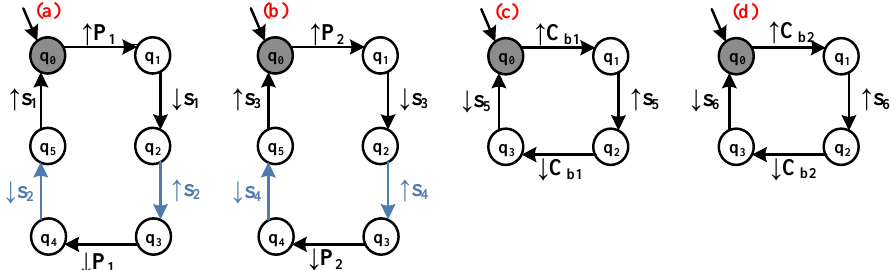
Figure 10. Local controllers LC N . ( a ) P 1 , ( b ) P 2 , ( c ) Cb 1 , ( d ) Cb 2.